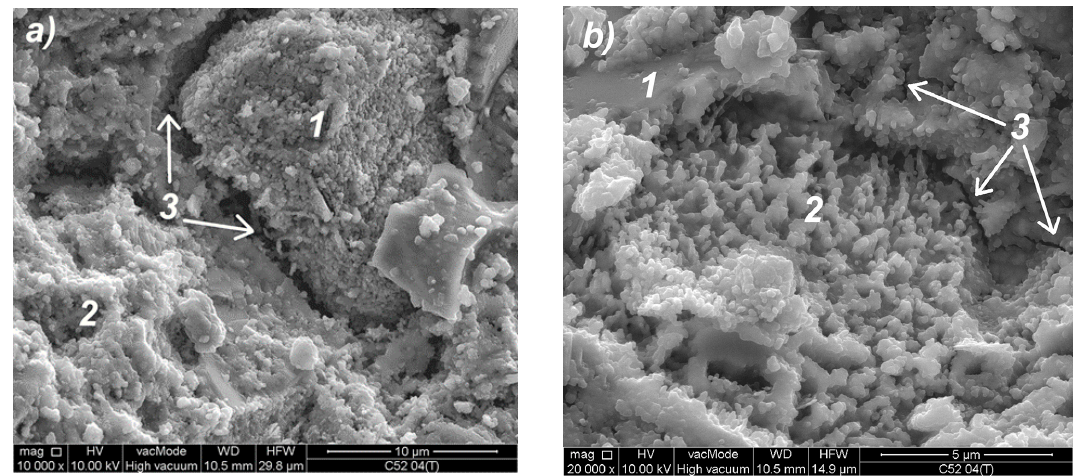
Figure 17. SEM photos of the C52 cement paste microstructure (descriptions of the indications in the text) for ( a ) magnification 10,000×; ( b ) magnification 20,000×.